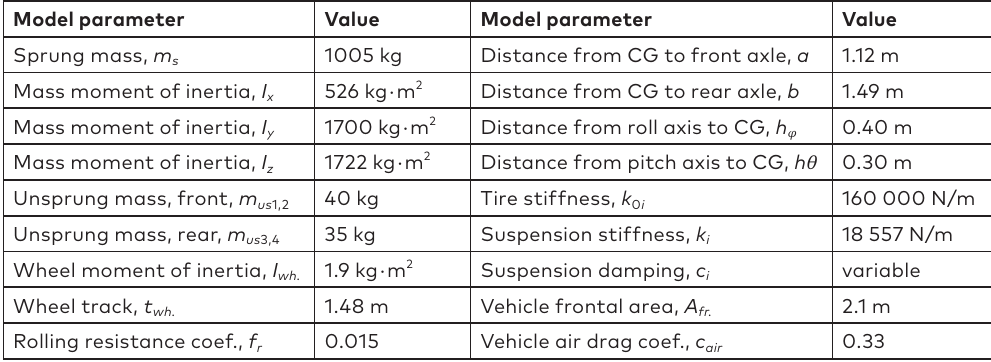
Table 2. Parameters for 14 DOF vehicle simulation model